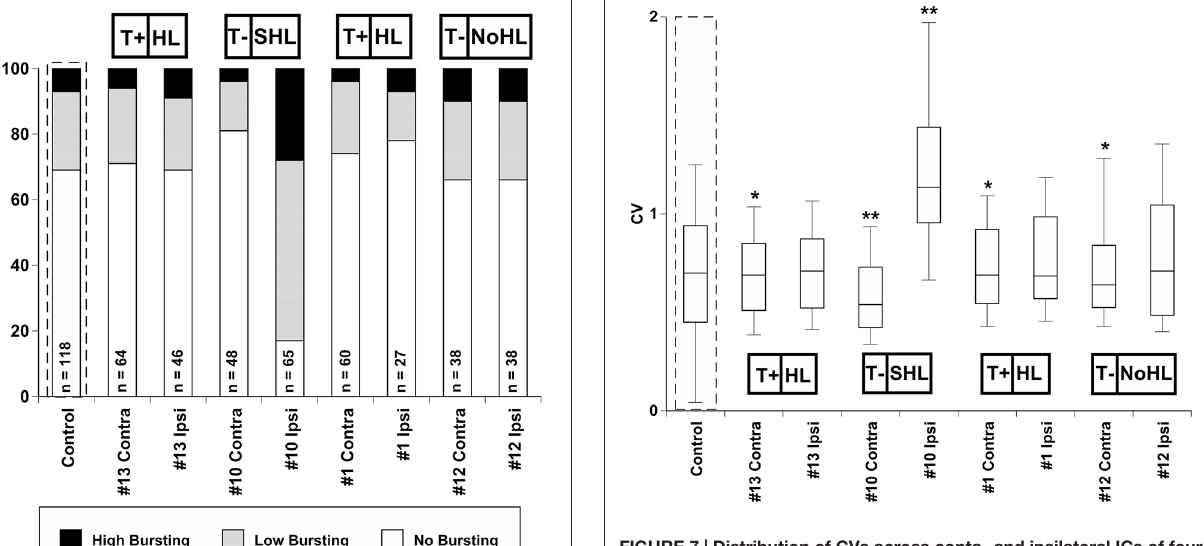
FIGURE 7 | Distribution of CVs across conta- and ipsilateral ICs of four exposed mice . The average CV from four control (unexposed) mice is outlined by a dashed line. Significant differences between control and each exposed IC was determined by a paired t -test ( ∗ 0.05, ∗∗ 0.001). Tinnitus and hearing loss abbreviations are taken from Figures 1 , 2